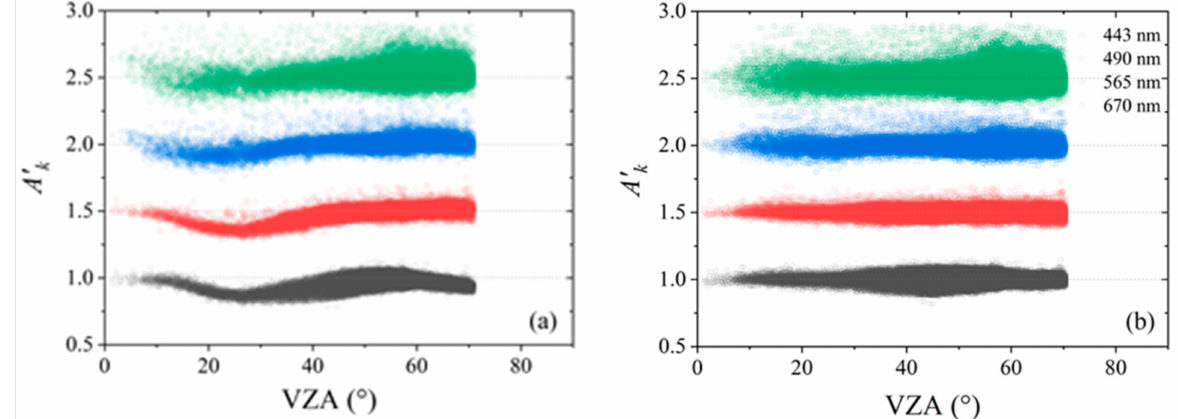
Figure 8. Comparison of the scatters of A (cid:48) via VZA for the Rayleigh calibration samples of k DPC/GaoFen-5, before ( a ) and after ( b ) the temporal drift correction of the absolute and relative radiometric response. The A (cid:48) plus 0, 0.5, 1.0, and 1.5 for the 443 nm (black points), 490 nm (red k points), 565 nm (blue points), and 670 nm (green points) bands, respectively, to make the scatters plots